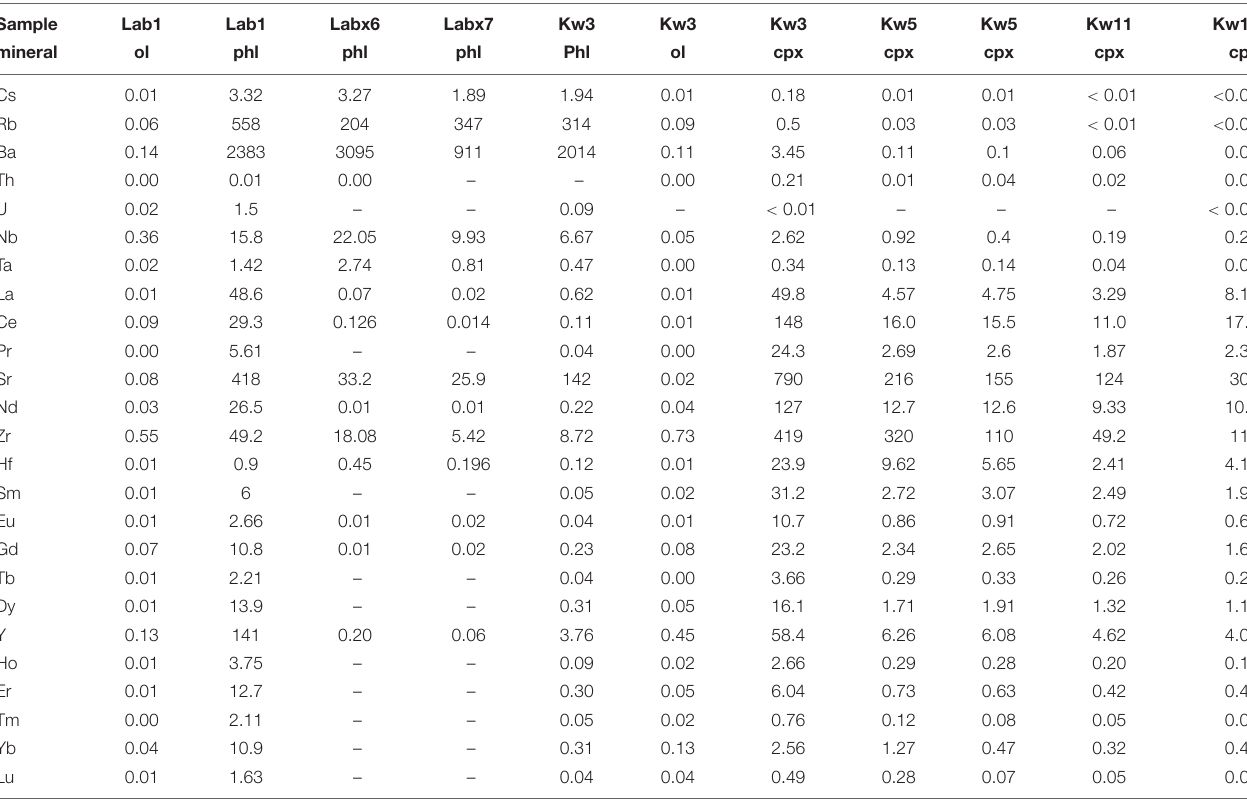
TABLE 3 | Trace element compositions of minerals. Sample